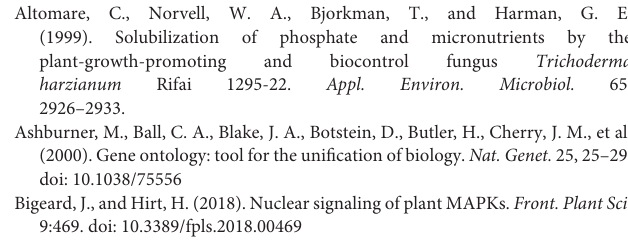
TABLE S3 | Physiological processes differentially affected in wheat seedling roots in response to the nitrogen concentration in the plant growth media, 0.5 or 1 mM calcium nitrate [Ca(NO 3 ) 2 ] compared to nitrogen source absence.